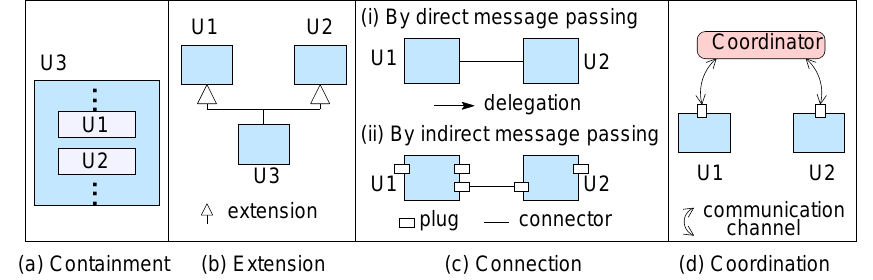
Figure 2. Four general categories of composition mechanisms.